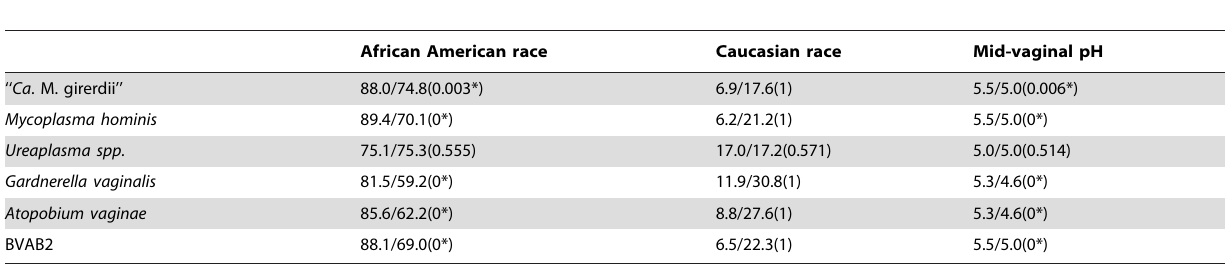
Table 3. ‘‘ Ca . M. girerdii’’ is associated with African American race and elevated vaginal